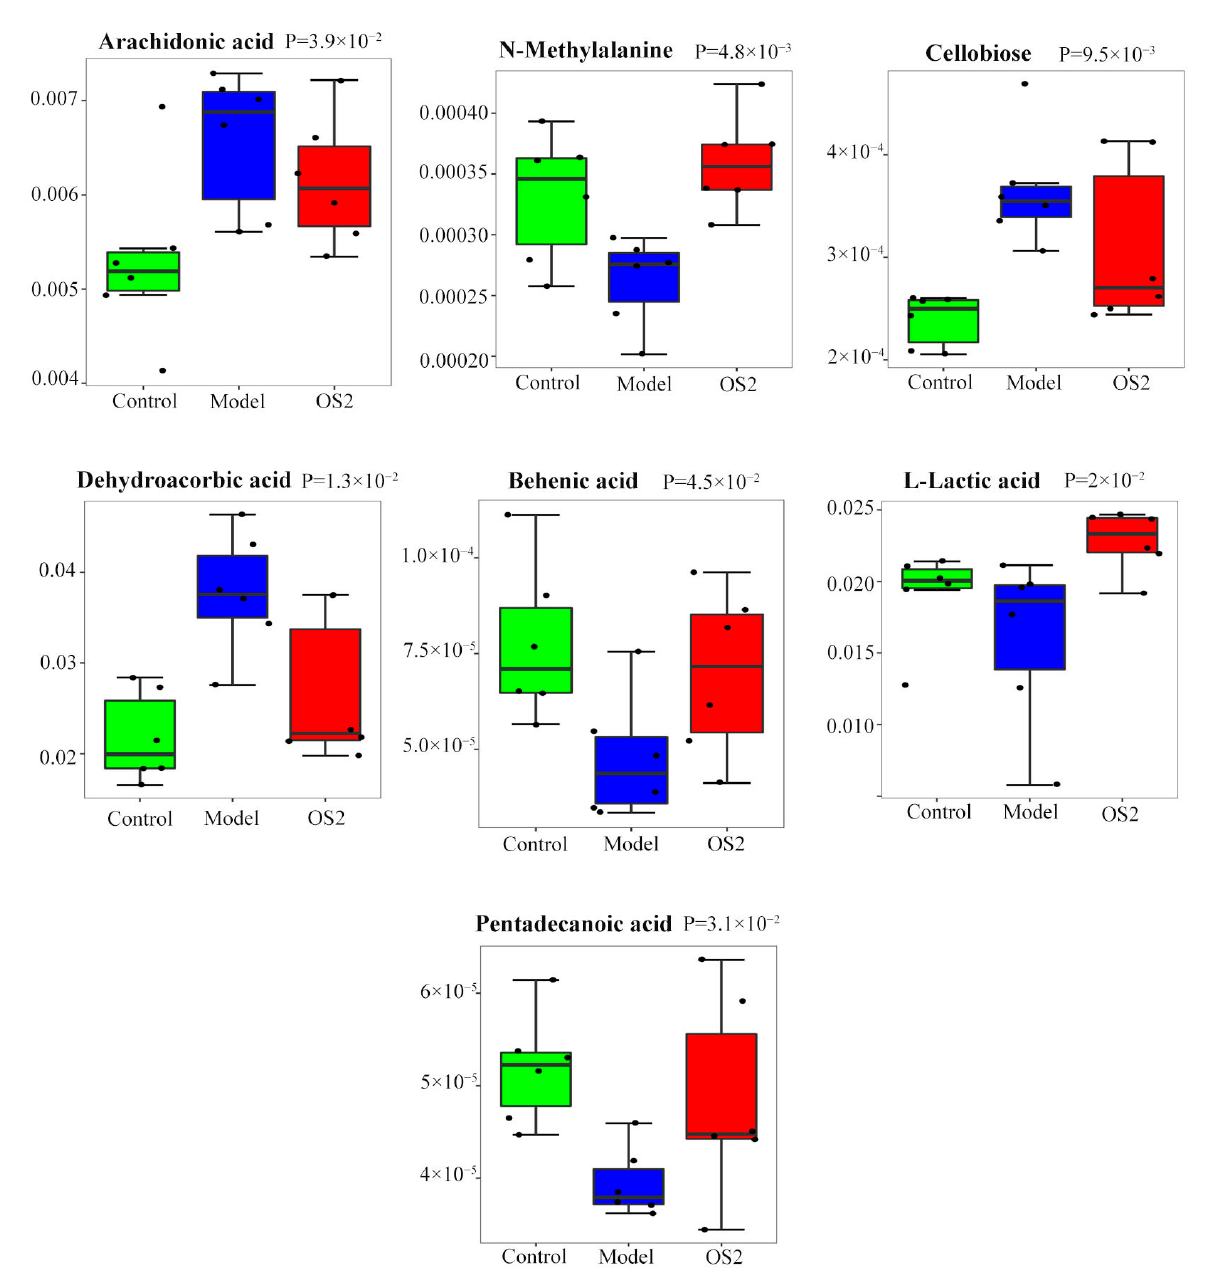
DA score plot of control and model. ( D ) Volcano plot of differential metabolites screened by uni- variate statistical analyses. ( E ) Volcano plot of differential metabolites screened by multivariate sta- tistical analyses (OPLS-DA).